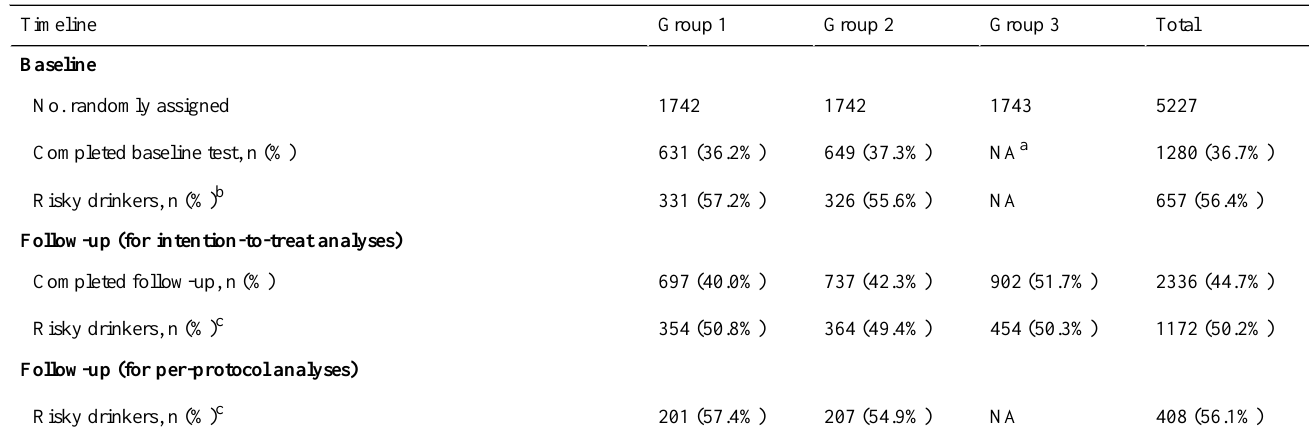
Table 1. Attrition rates of all groups: group 1 (assessment and feedback), group 2 (assessment-only), and group 3 (no contact).